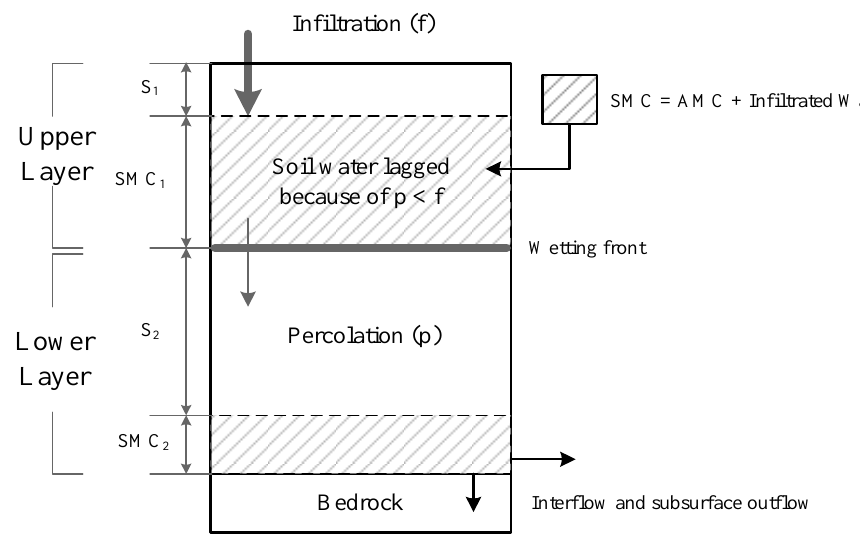
Figure 9. Conceptual diagram of a soil column considering the soil layers in the first section: This study assumed that the soil column consists of two layers, an upper layer (saturated by infiltration) and a lower layer (saturated by percolation). S indicates the soil moisture retention (SMR) and SMC means Soil Water Content consisting of antecedent moisture content (AMC) and the infiltrated water. The wetting front based on Green and Ampt [49] represents the boundary between two layers causing the retardation effect by the difference of infiltration and percolation rates.